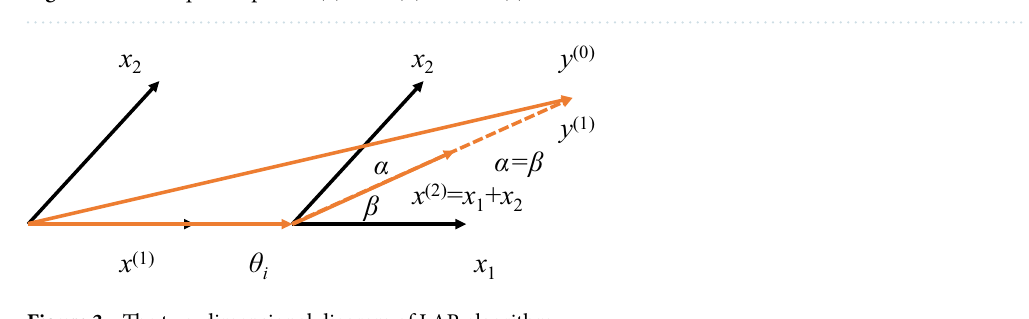
Figure 2. The acquired spectra, ( a ) XRF, ( b ) visNIR, ( c ) OPA.